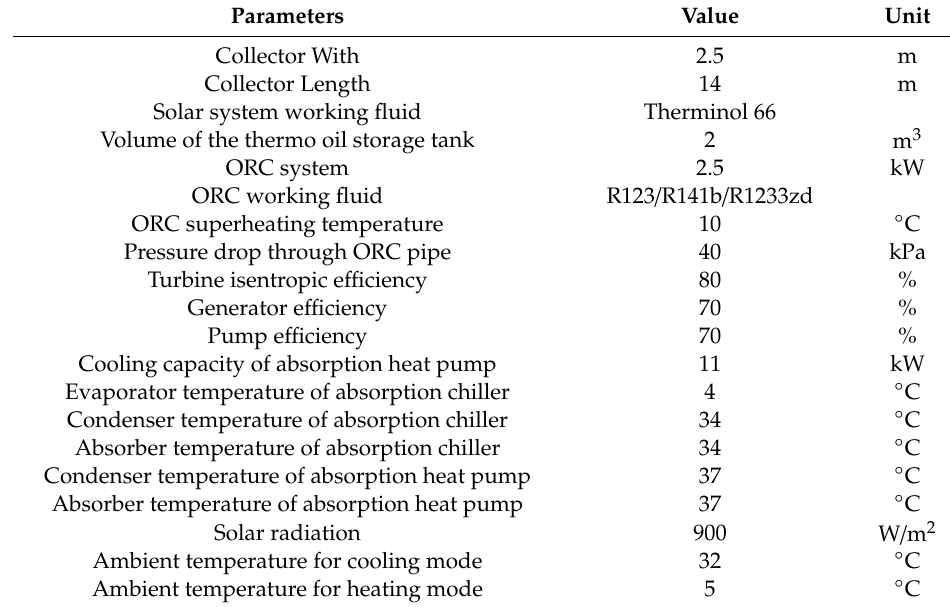
Table 3. System parameters and operating conditions for the